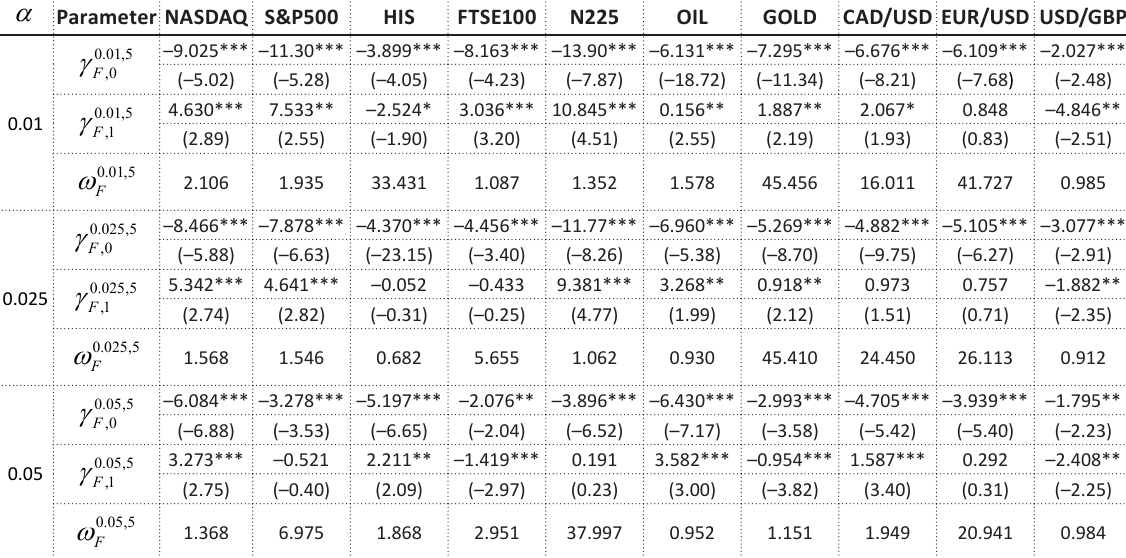
Table A3. Parameter estimation of F-MIDAS-Q model under the 5-step holding period α Parameter NASDAQ S&P500